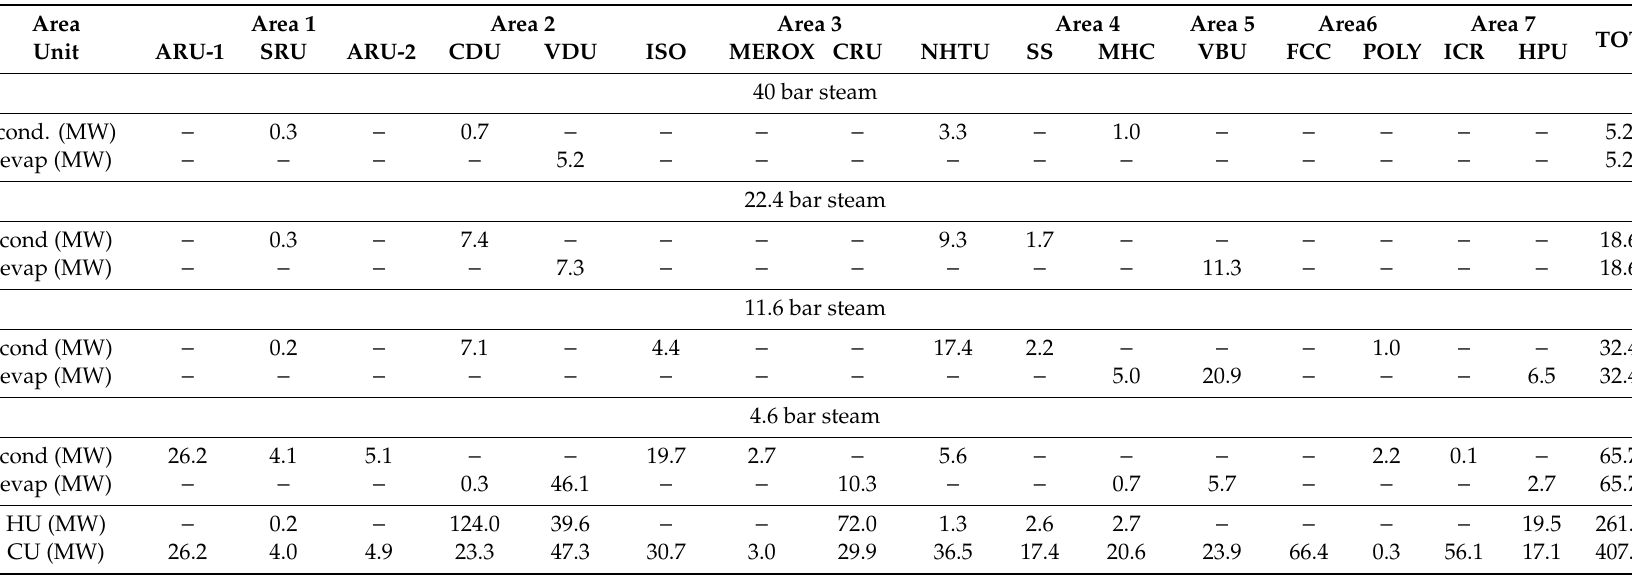
Table 2. Possible optimal distribution of steam consumption and production in di ff erent refinery units for the case in which direct heat exchange is allowed within process units only and a site-wide steam network configuration without turbines is considered (case b -3, ∆ T min = 10 ◦ C). Below, cond = condensation, i.e., steam consumption and evap = evaporation, i.e., steam